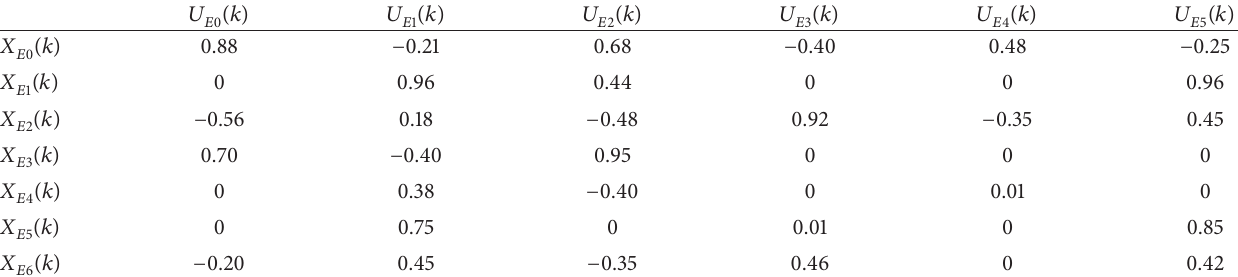
of the sensitivity of internal stimuli. OF